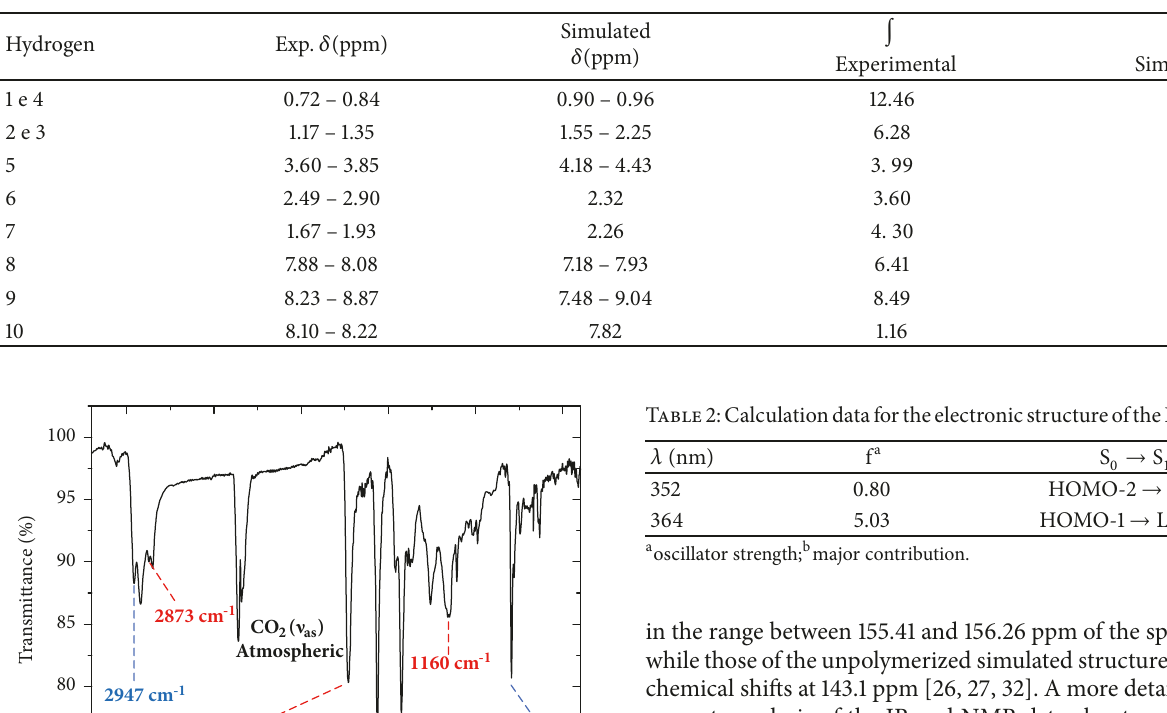
Table 1: Chemical shifts of 1 H NMR of the LaPPS71.